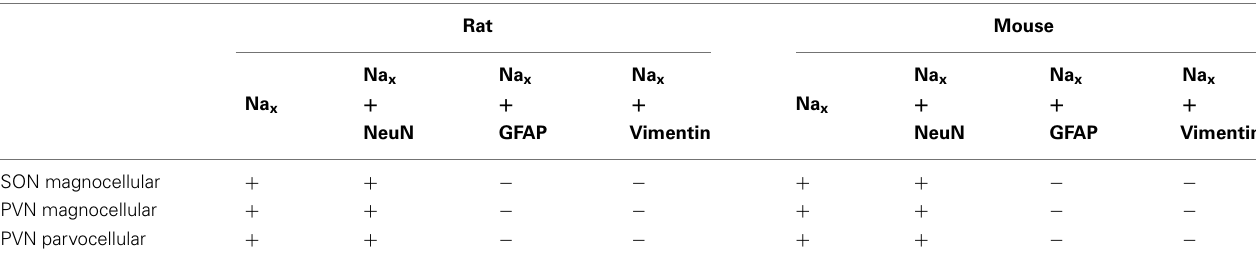
Table 4 | Colocalization of Na X immunostaining with fluorescent cell markers in the SON and the